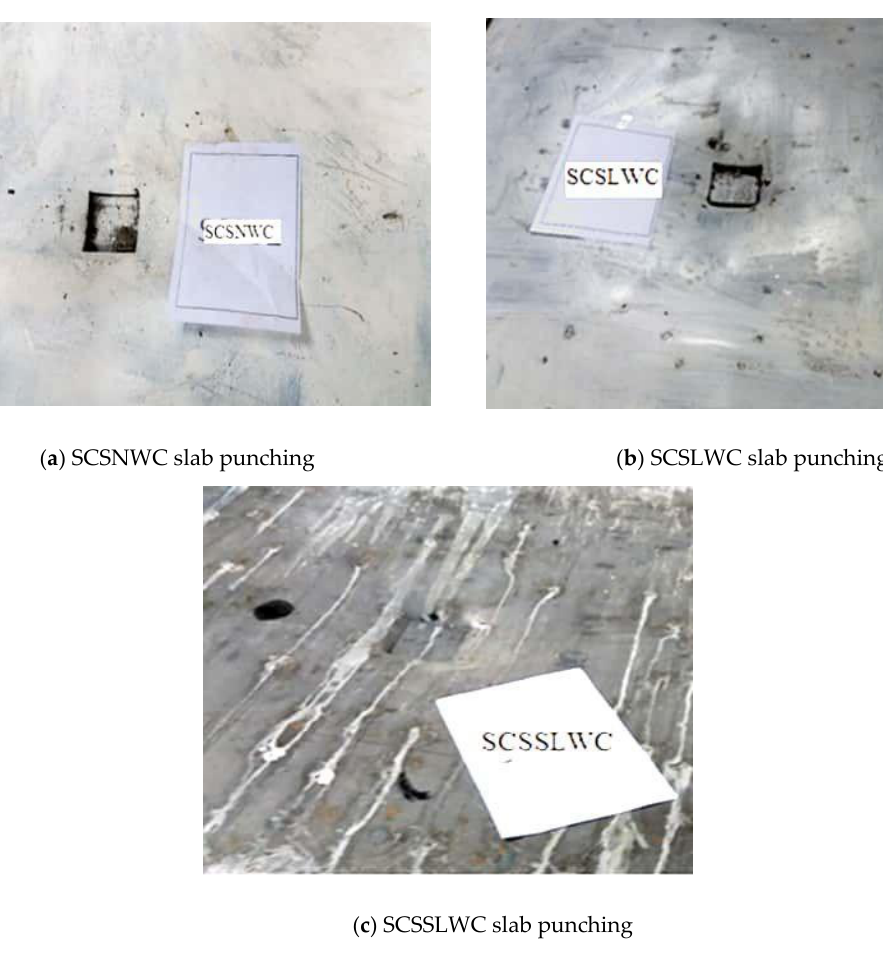
Figure 13. Punching shear failure mode in the specimens.